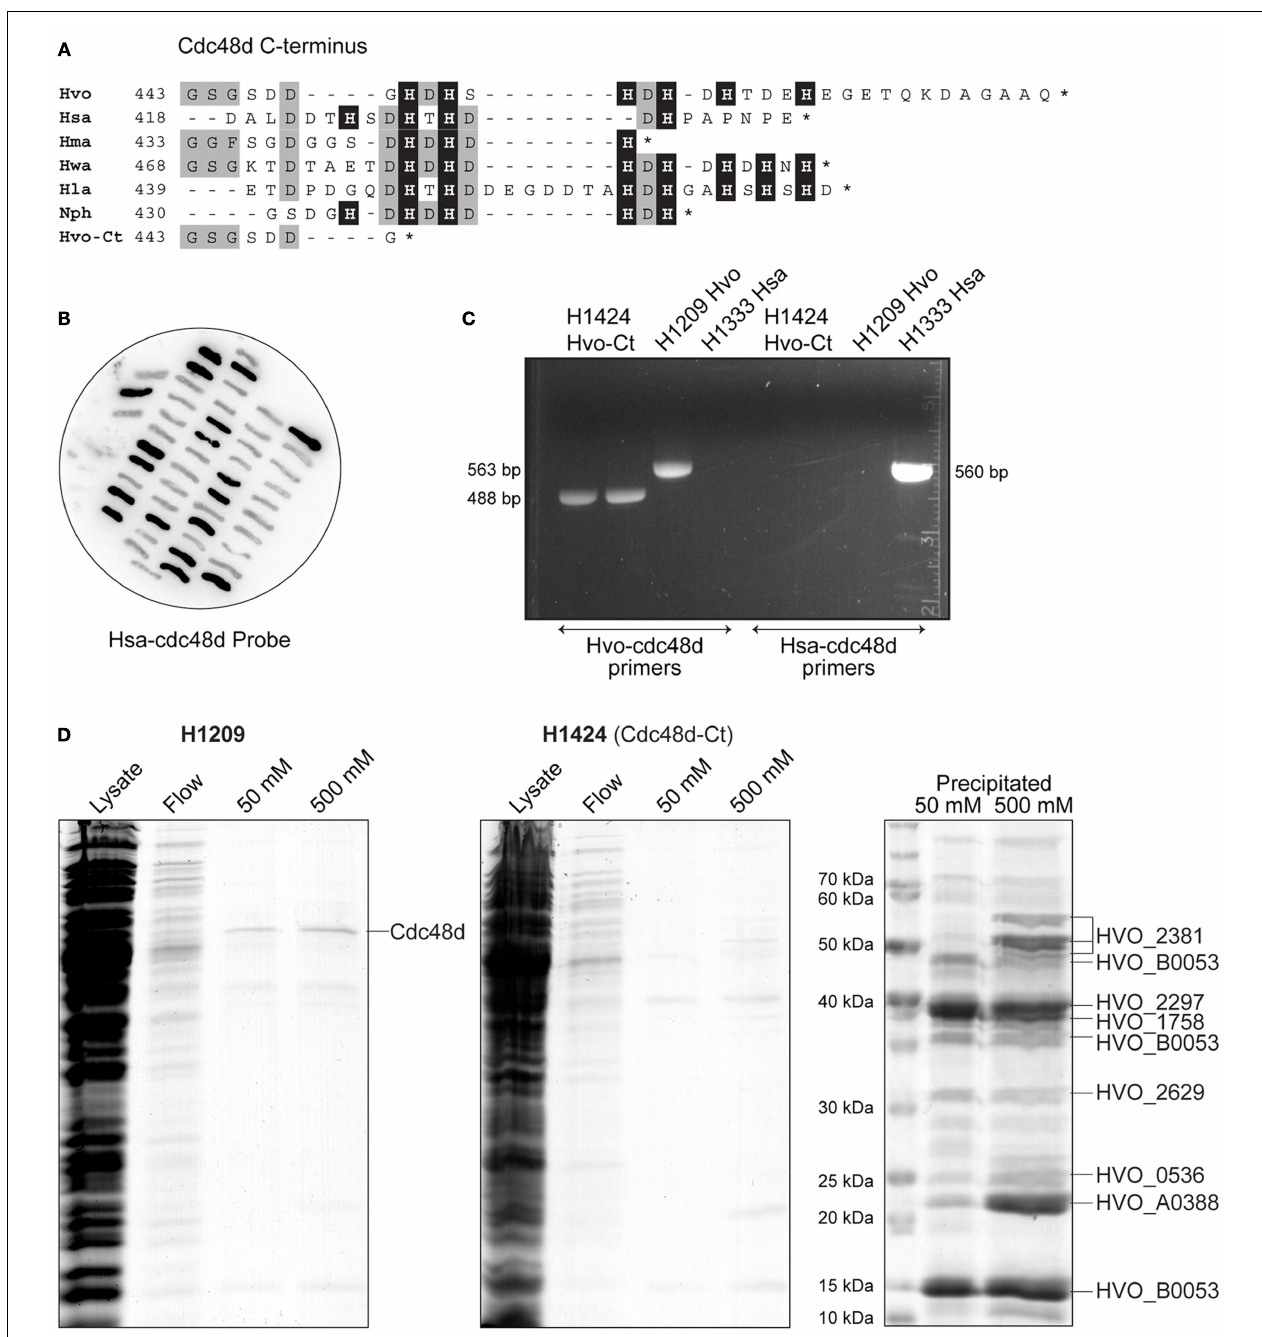
FIGURE 5 | (A) Protein sequence alignment of C-terminus of Cdc48d from selected species of haloarchaea (Hvo, H. volcanii ; Hsa, Halobacterium salinarum ; Hma, Haloarcula marismortui ; Hwa, Haloquadratum walsbyi ; Hla, Halorubrum lacusprofundi ; Nph, N. pharaonis ; Hvo-Ct, H. volcanii C-terminal truncation Cdc48d-Ct). Histidine residues are indicated by a black background. (B) Colony hybridization of 5-FOA-resistant clones of H. volcanii H1333, after pop-in/pop-out gene replacement with pTA1294. H. salinarum cdc48d sequences ( Hsa-cdc48d ) were used as a probe, clones failing to hybridize therefore carry the truncated H. volcanii cdc48d-Ct allele present in pTA1294. (C) Verification of truncated cdc48d-Ct allele in H1424 by PCR (488bp product), with primers specific to either H. volcanii or H. salinarum genes.